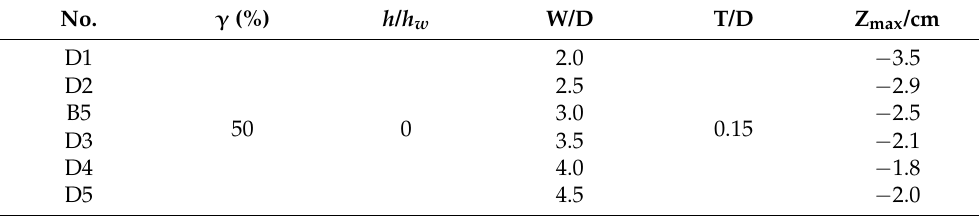
Figure 14. Local scour around the pier using the permeable collar with different diameters. Table 4. Maximum scour depth around the pier using the permeable collar with different diameters. No.